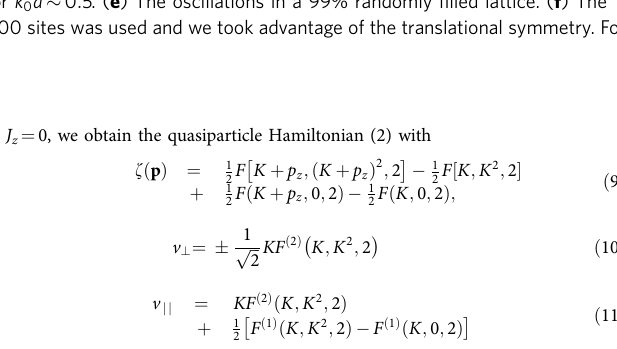
E 2 )/(2 p ), where E 1 E 2 is the energy splitting between the two branches of the k (cid:3) k k (cid:3) k